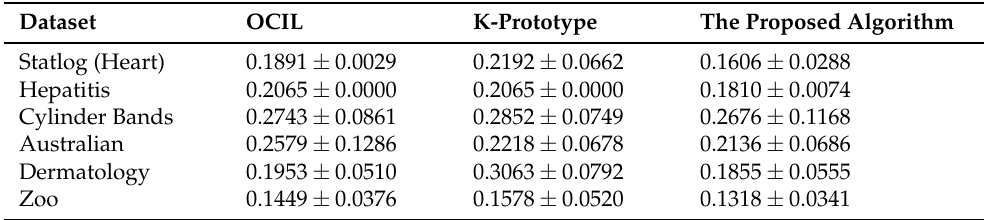
Table 2. Comparison of cluster accuracy for the proposed algorithm with OCIL and K-Prototype on mixed